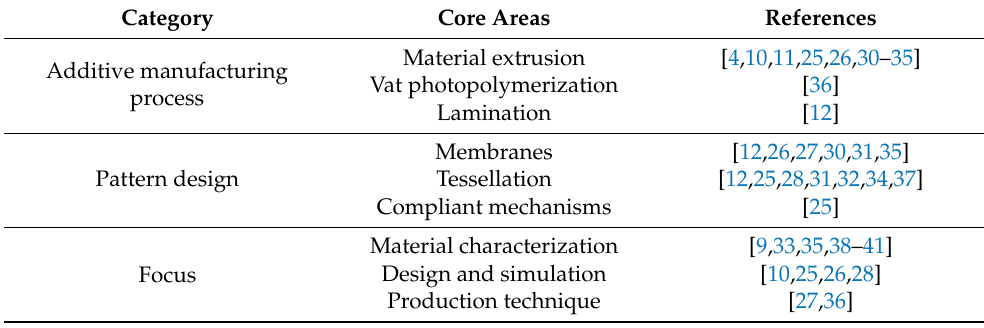
Table 1. Categorization of research on 4D textiles made by additive manufacturing on textiles. Category